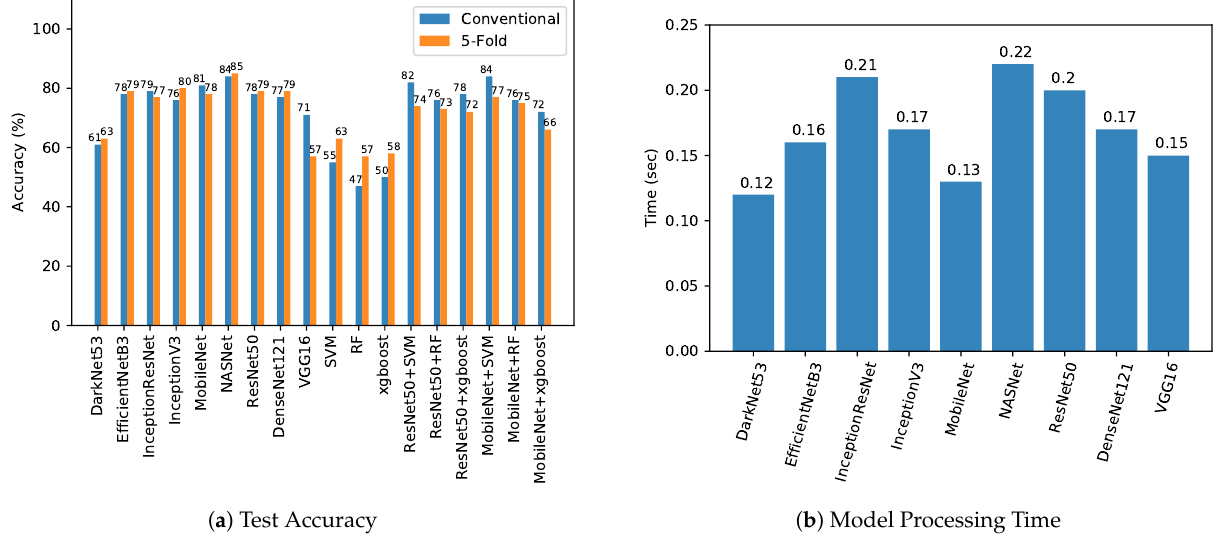
Figure 8. Graphical comparison of implemented CNN models for test